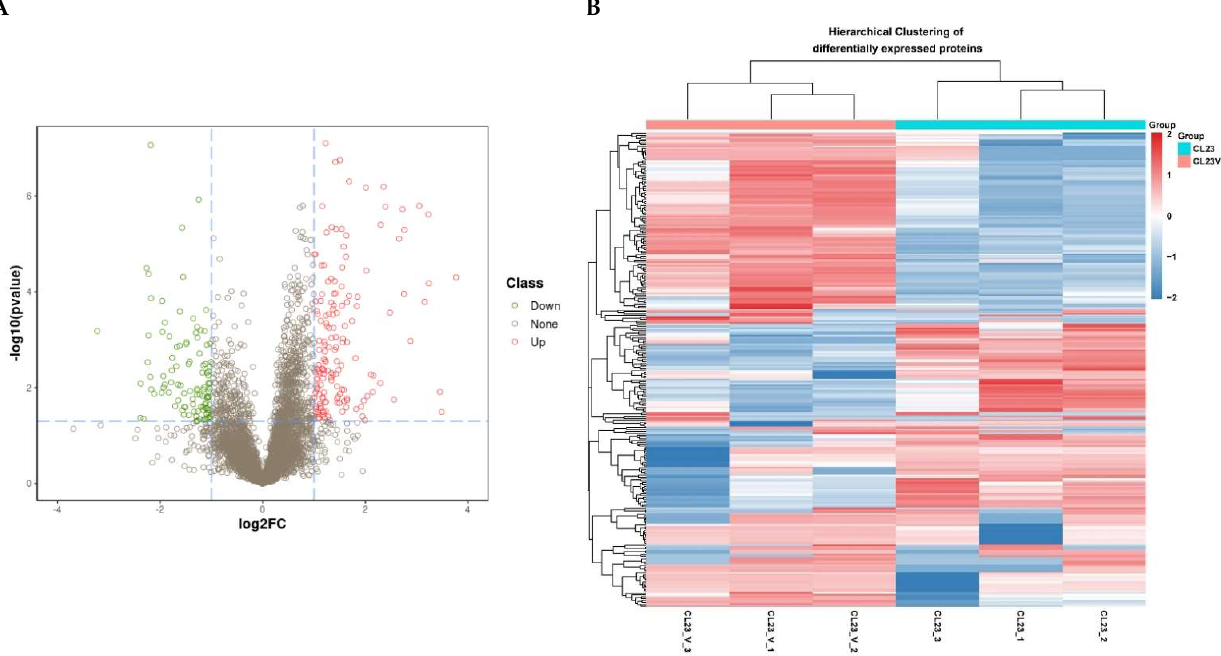
Figure 1. Proteomic - analysis of MDCK cells infected with Influenza A virus (IAV) H1N1 relative to uninfected MDCK cells. ( A ) The volcano plot represents the significance and magnitude of protein level changes in uninfected MDCK cells (MDCK mock) and IAV H1N1-infected MDCK cells 16 h post infection (hpi) (MDCK H1N1 16 hpi). Green dots represent downregulated differentially ex- pressed proteins, red dots represent upregulated differentially expressed proteins, and “None” rep- resents proteins with no significant expression differences between the two groups of cells. ( B ) The heat map represents significant protein differences between MDCK mock and MDCK H1N1 16 hpi cells. The color scale indicates the relative protein abundance, with darker shades representing the greatest difference in protein abundance between the two groups; red indicates up-regulation and blue indicates downregulation. The student’s t -test was used to identify statistical significance.